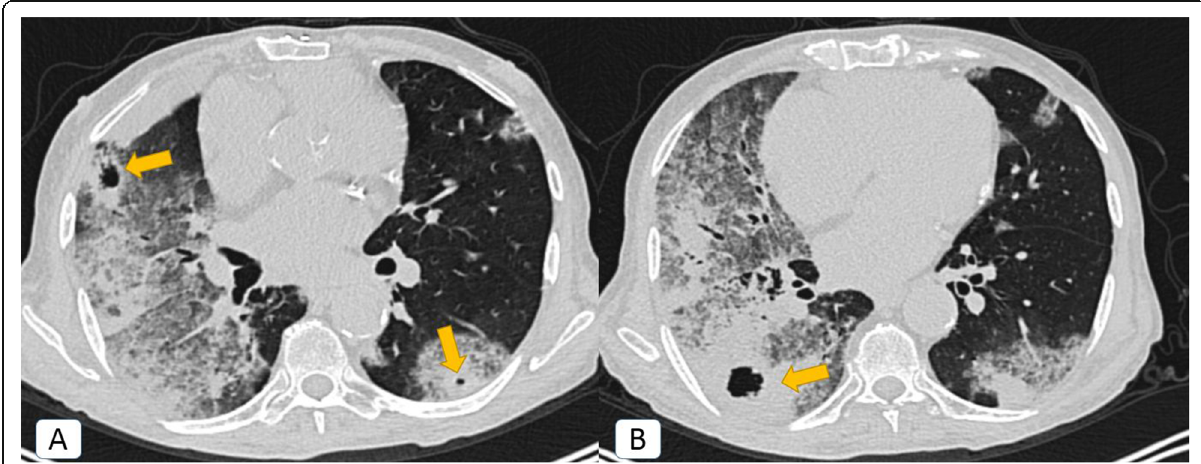
Fig. 7 COVID-19 infection atypically presented by cavitation: a 62-year-old male COVID-19 patient. A , B Axial chest CT (lung window) showing bilateral widespread mixed ground glass and consolidative patches are noted (more pronounced on the right side). Secondary cavitary changes are noted (orange arrows)